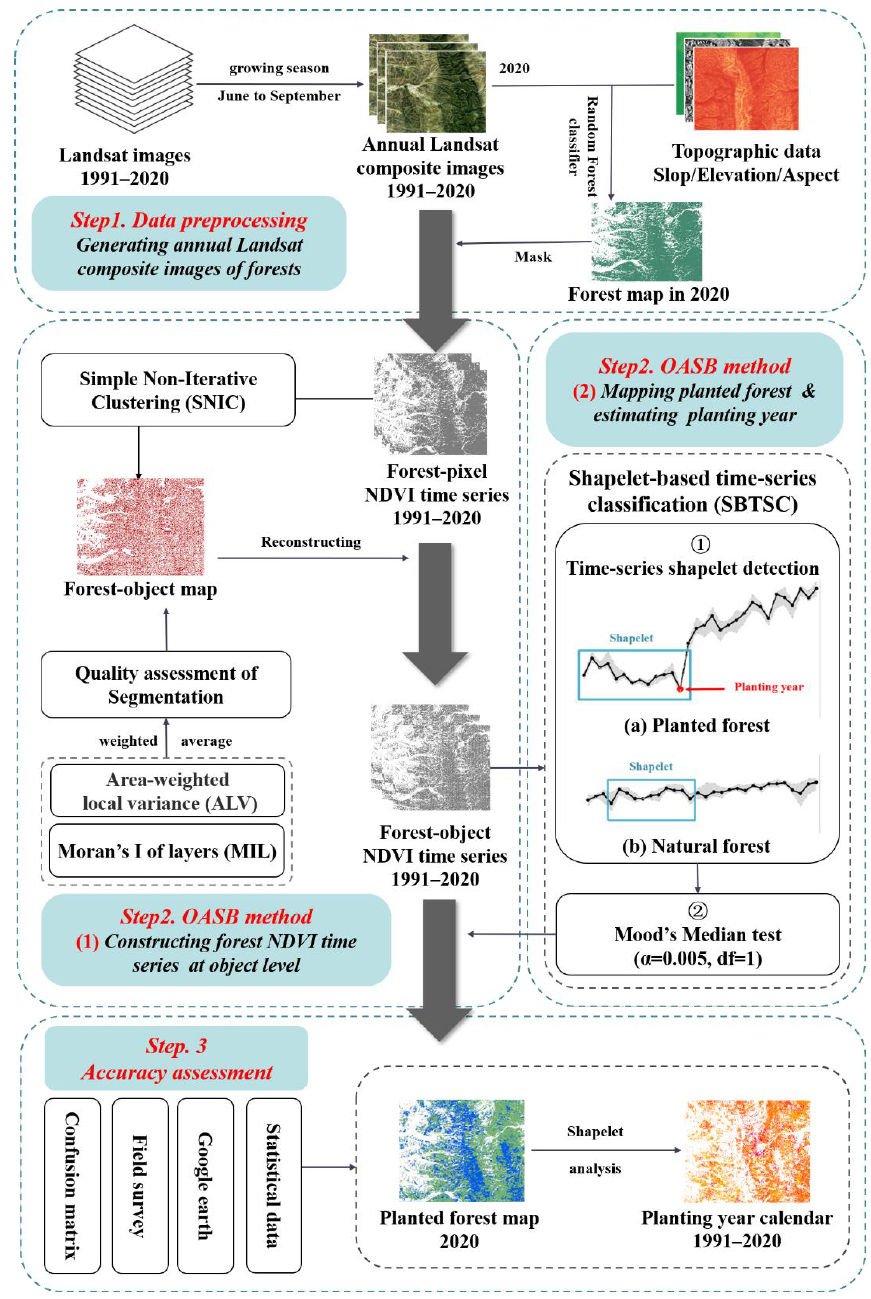
Figure 2. Workflow of the procedures developed in this study to map the planted forest